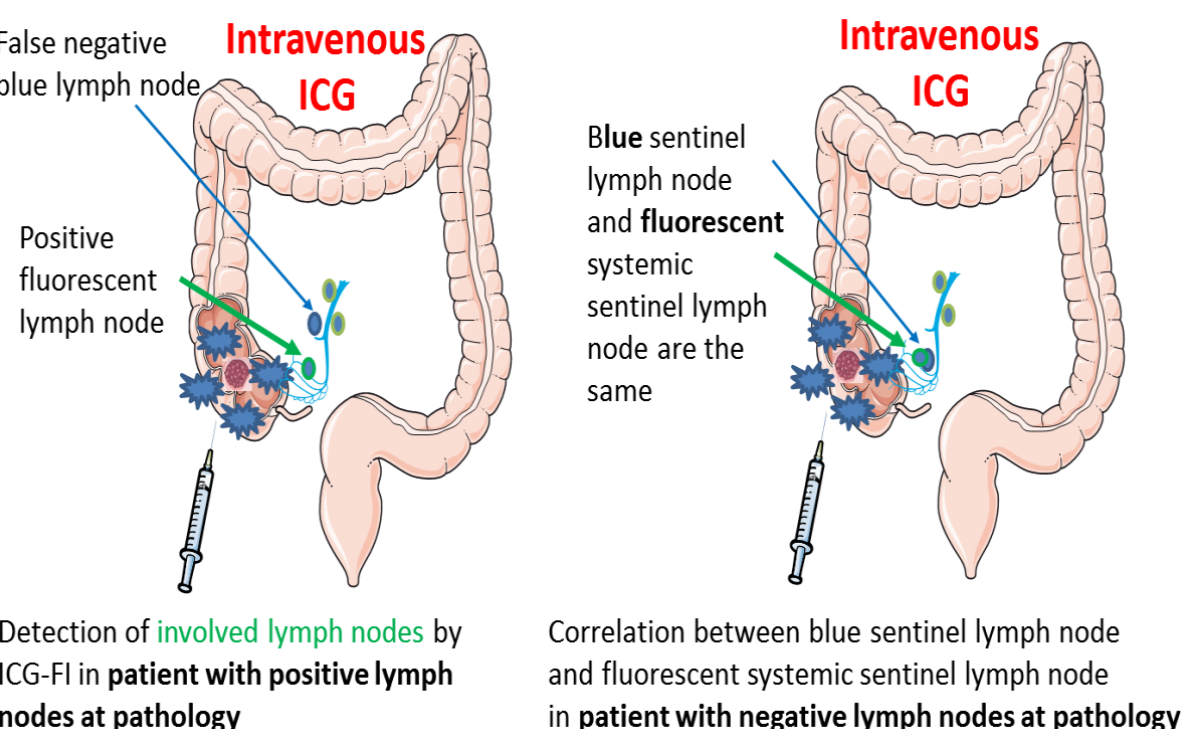
Figure 1. Illustrations of the systemic sentinel lymph node hypotheses. In patients with small tumors, we expect to find a correlation between the blue sentinel lymph node and the systemic lymph node. In patients with large tumors, we expected to have a false negative blue sentinel lymph node and a true positive systemic lymph node. FI: fluorescence imaging; ICG: indocyanine